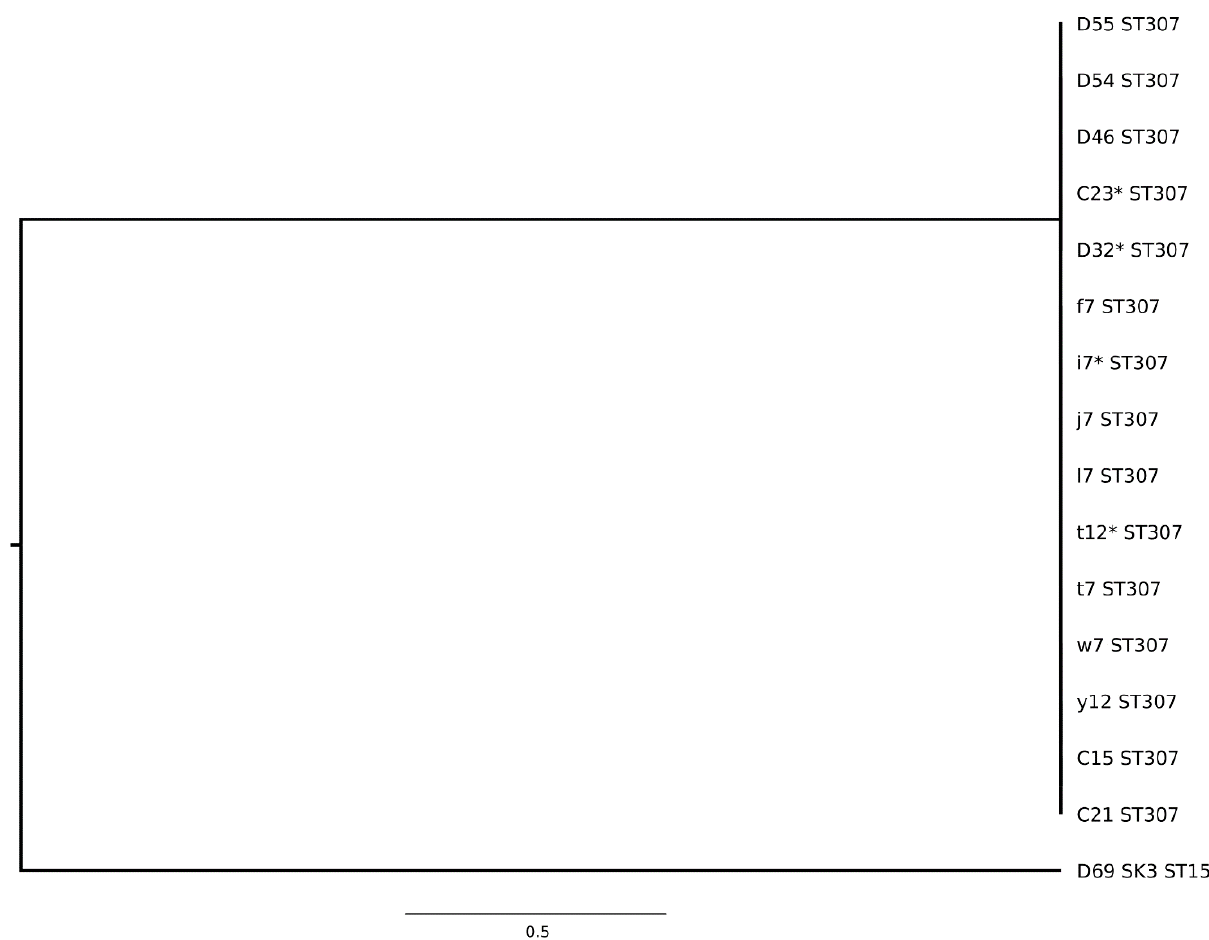
Figure 3. Multi-locus sequence typing-distance based phylogenetic tree for extended-spectrum beta-lactamase-producing Klebsiella pneumoniae isolates. D, dog; C, cat; O, owner; lower case letter, environment; D55, dog 6; D54, dog 8; D46, dog 6; C23, cat 5; D32, dog 4; f, water tap; i, small cabinet; j, area of drug preparation; l, fridge with medication; t, blood pressure monitor; w, scale (floor); y, scissors; C15, cat 1; C21, cat 4; D69 SK3, dog 11; *, whole genome sequencing conducted.